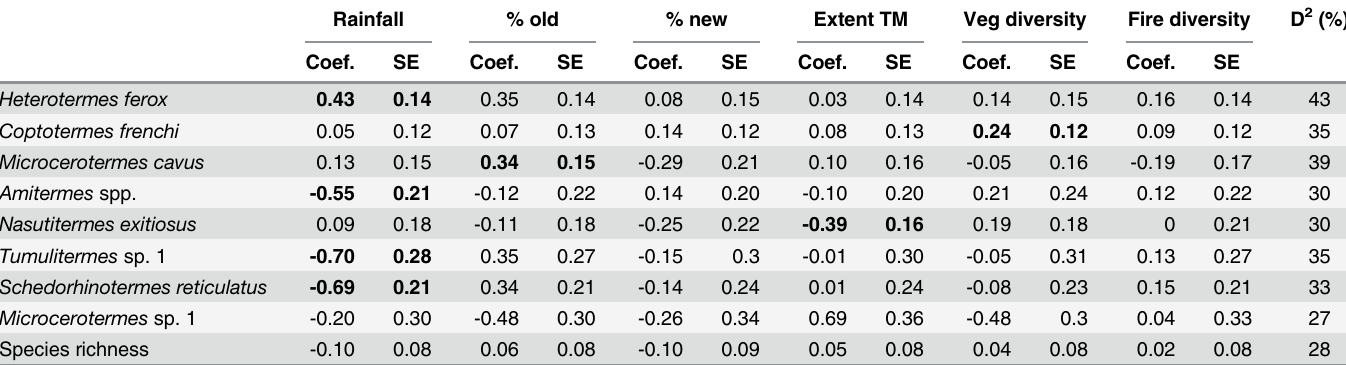
Table 6. Summary of generalised linear models for termite species at the landscape scale. Coefficients of important explanatory variables (and stan- dard errors) shown in bold are those for which the 95% confidence intervals of model-averaged coefficients did not include zero. D 2 values indicate model fit of the full model. Descriptions of explanatory variables are given in Table